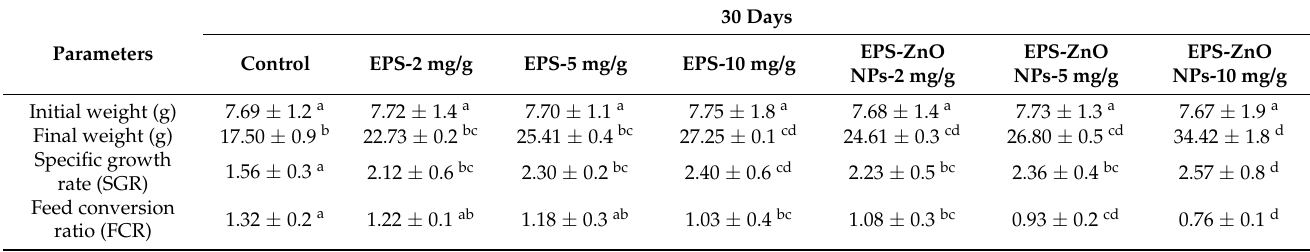
Table 1. Growth performance of O. mossambicus fed with the experimental diet (EPS and EPS-ZnO NPs) after 30 days of feeding trial. Different letters correspond to the statistical difference between treated